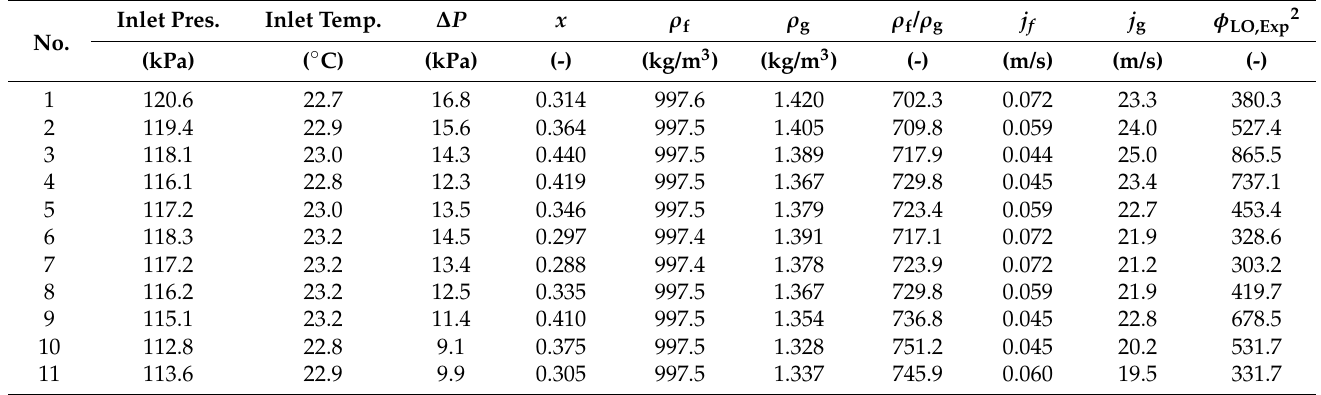
Table 5. Two-phase test results for the full-scale test